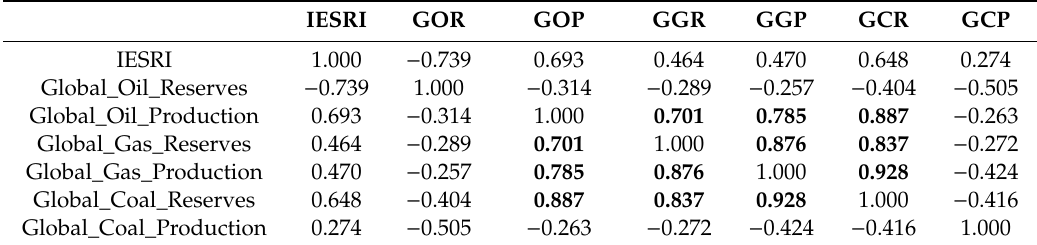
Table 4. Pearson Correlation parameters from the Global Fuels group.